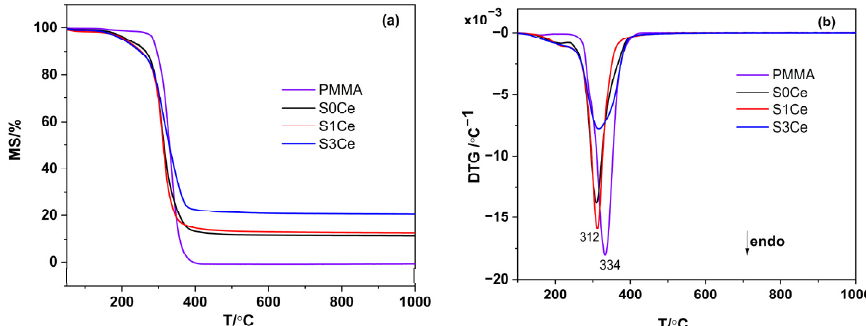
Figure 2. TG/DTA analyses of the pristine PMMA and PMMA-MBGs composite scaffolds: ( a ) TG analysis; ( b ) DTA analysis.